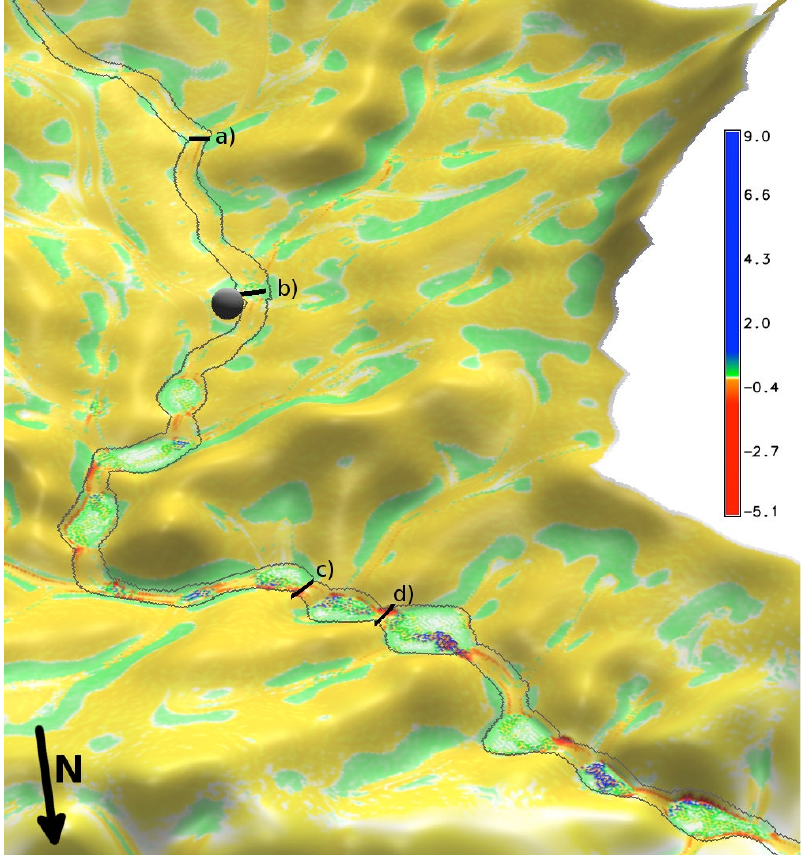
Figure 6. An oblique, three-dimensional view of a portion of the region shown in Figure 4. Warm colors (yellow through red) indicate cumulative erosion, and cool colors (green through blue) indicate cumulative deposition. The locations of the four cross-sections are indicated, as is the position of the Neolithic site of Mas D’is. Note that channel erosion occurs most intensively where narrowing of the channel bottom, coincides with a rapid convex change in slope in the channel gradient (e.g., points “c” and “d”). These are similar to the process of “head cuts” in real channels (e.g.,